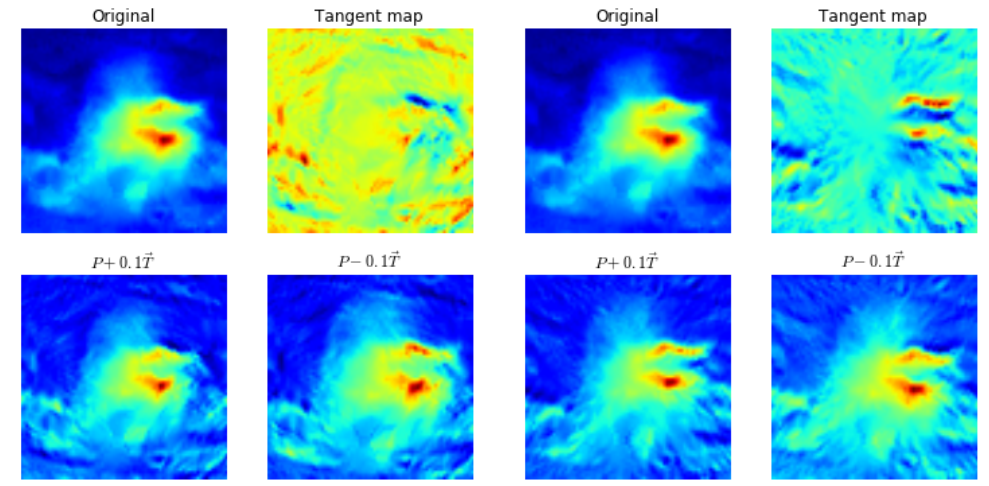
Figure 7. Diagonal hyperbolic transform ( left group ); and parallel hyperbolic transform ( right group ) at “2016-01-19